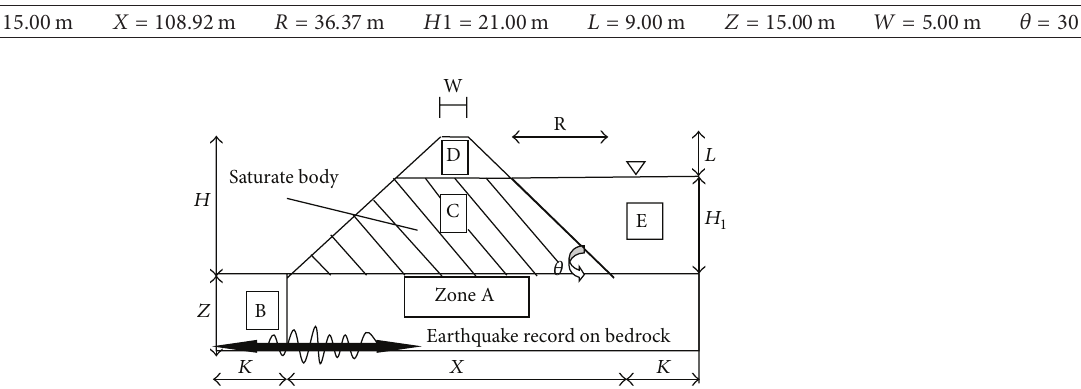
Figure 1: A modeling dimension according to Table 1 for plan strain